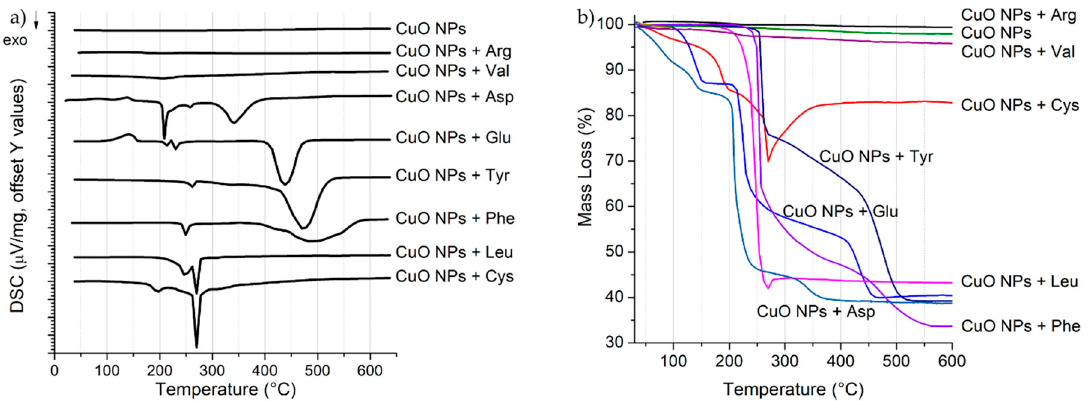
Figure 3. ( a ) Differential Scanning Calorimetry (DSC) and ( b ) Thermo-Gravimetric Analysis (TGA) analysis of CuO NPs and CuO NPs with the different amino acids. analysis of CuO NPs and CuO NPs with the di ff erent amino